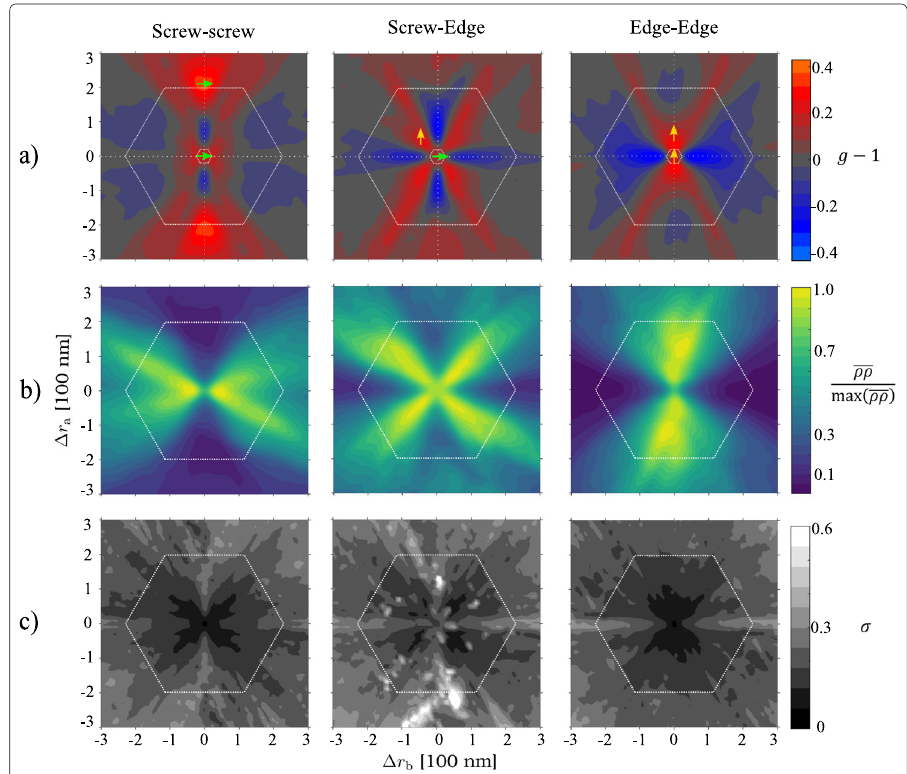
Fig. 8 Quantities relevant to the certainty of the correlation calculations. For reference, the correlation functions are shown again in ( a ). The empirical mean of the coarse density product ρ i ρ j normalized by the maximum value is shown in ( b ), and the standard error of the correlation calculation in ( c ). When the average density product ( b ) becomes small, this leads to a significantly increased standard error in the calculation, as it appears in the denominator of the correlation calculation of Eqs. (40-41). Notably, several regions of the separation space on the plane are seen to have standard error values comparable to the magnitude of the correlation, namely in the unconnected directions (the y-axis in the screw-screw case and the x-axis in the edge-edge case). All quantities shown are calculated for the coarsest calculation ( L =162